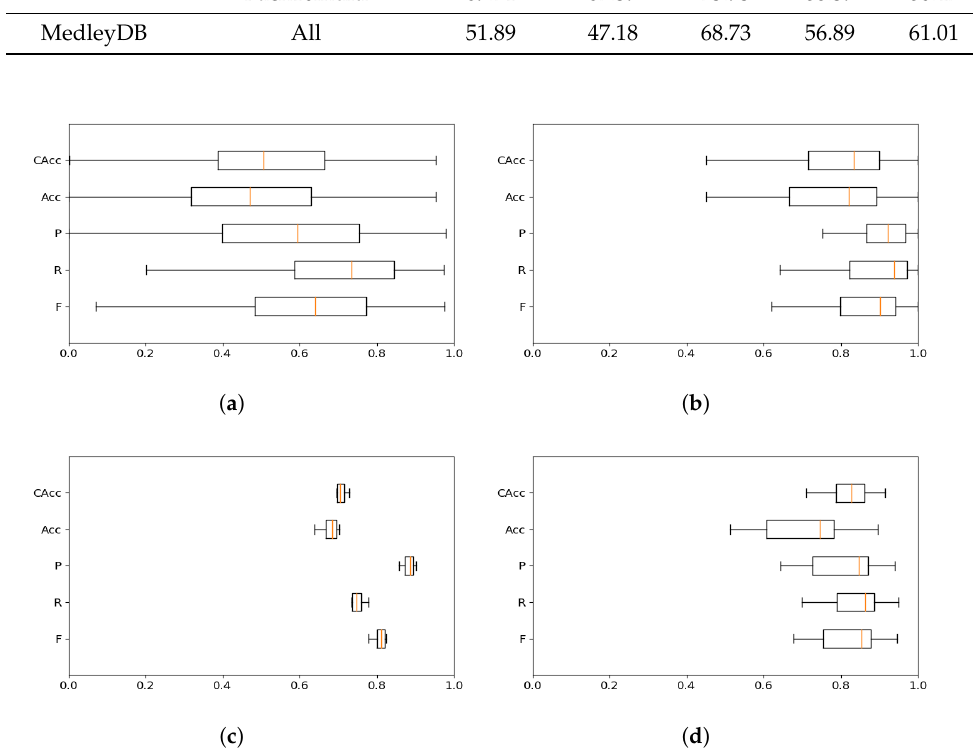
Figure 8. Multi- f 0 metrics for: ( a ) MedleyDB dataset, ( b ) Pianos of Slakh2100 dataset, ( c ) Bach10 multi dataset and ( d ) Bach10 single dataset. The horizontal axis in all subfigures correspond to the value of each metric that is represented in the vertical axis of the box plot. The displayed metrics are: Chroma Accuracy (CAcc), Accuracy (Acc), Precision (P), Recall (R) and F-score